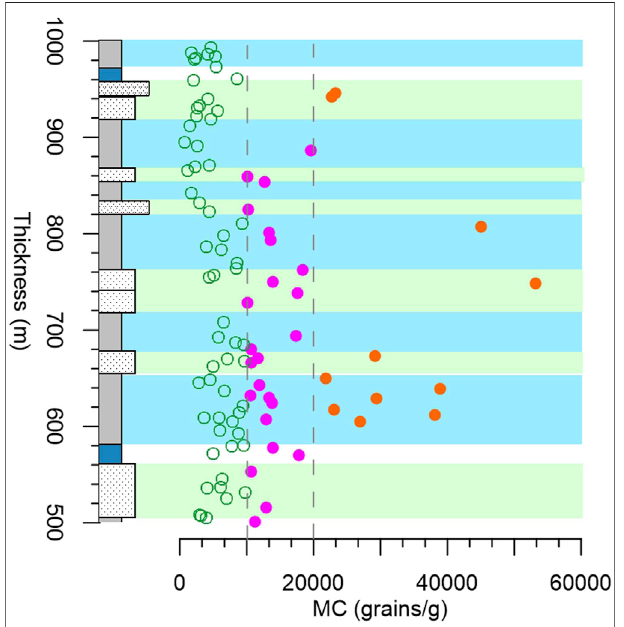
FIGURE 3 | Correlations between lithological stratigraphy and MC at 500 – 1,000 m of the HTG section. No regular MC change with the lithology, the high values can exist in either mudstone or sandstone.